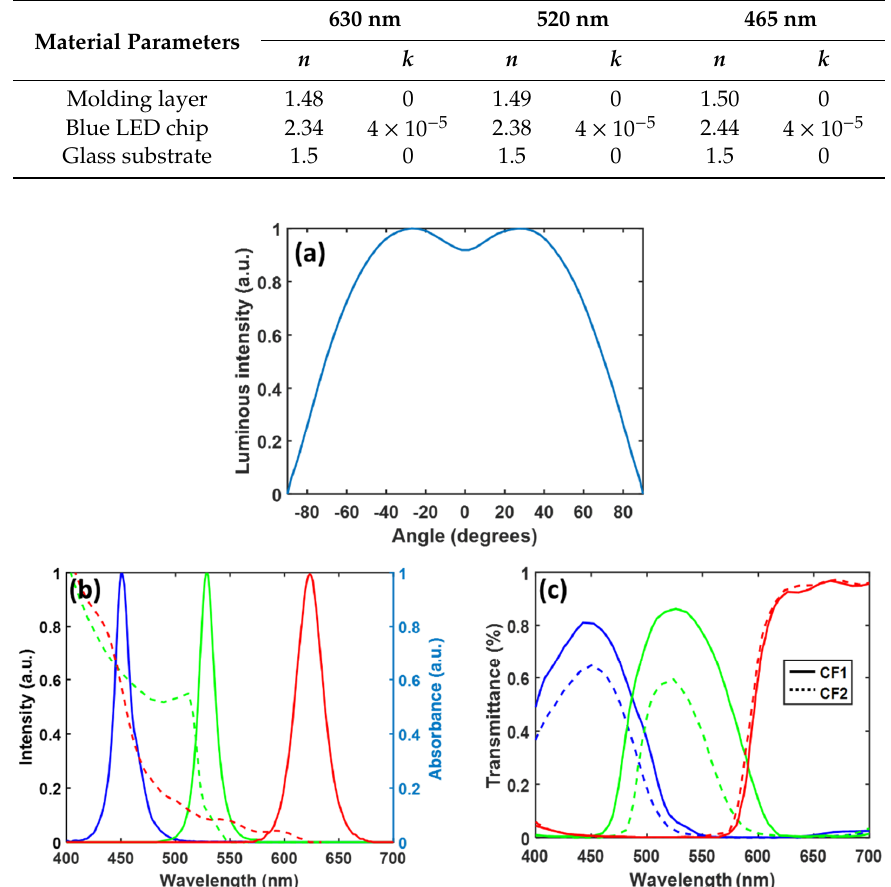
Table 1. Material parameters used in the blue micro-LED array.